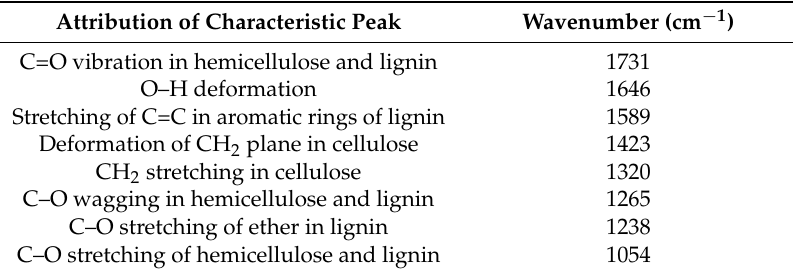
Table 2. Attribution of characteristic peaks of HHB.